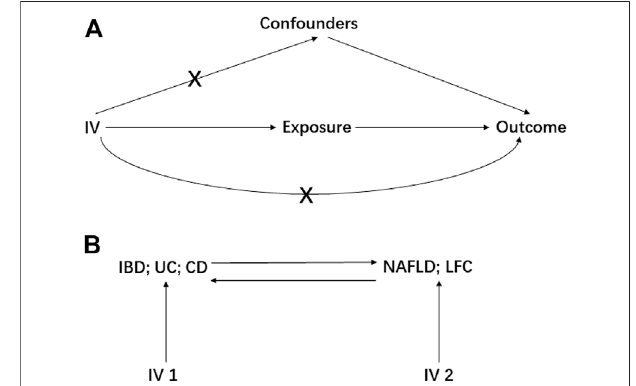
FIGURE1| ThebasicprinciplesofMendelianrandomization(MR)study. A represents the three principal assumptions; B represents the bi-direction MR design. IV is instrumental variable; IBD is in fl ammatory bowel disease; UC is ulcerative colitis; CD is Crohn ’ s disease; NAFLD is non-alcoholic fatty liver disease; LFC is liver fat